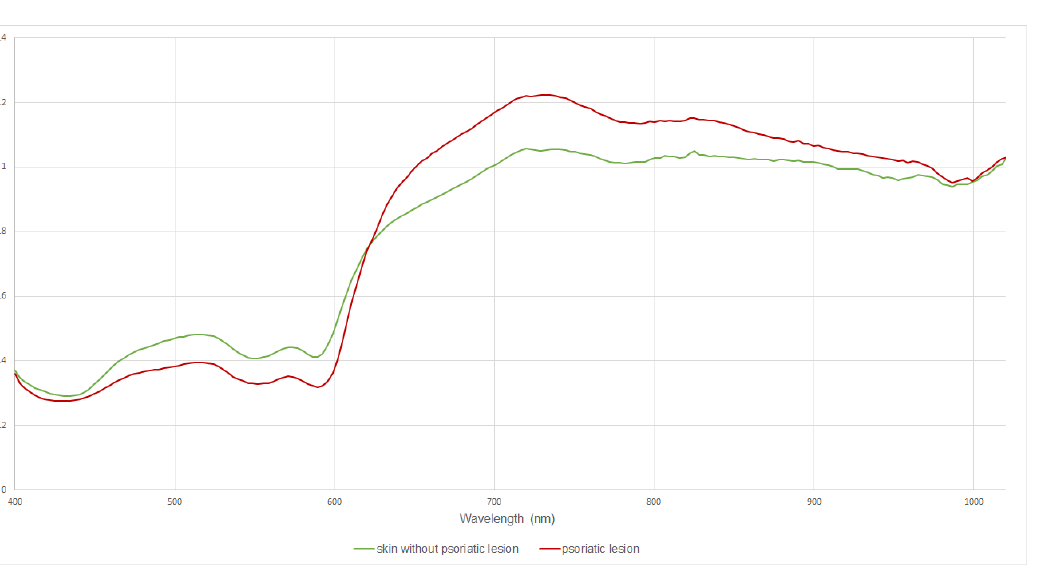
Figure 7. Comparison of reflectance profiles in psoriatic lesion and skin without psoriatic changes in the spectral range 400–1000 nm.